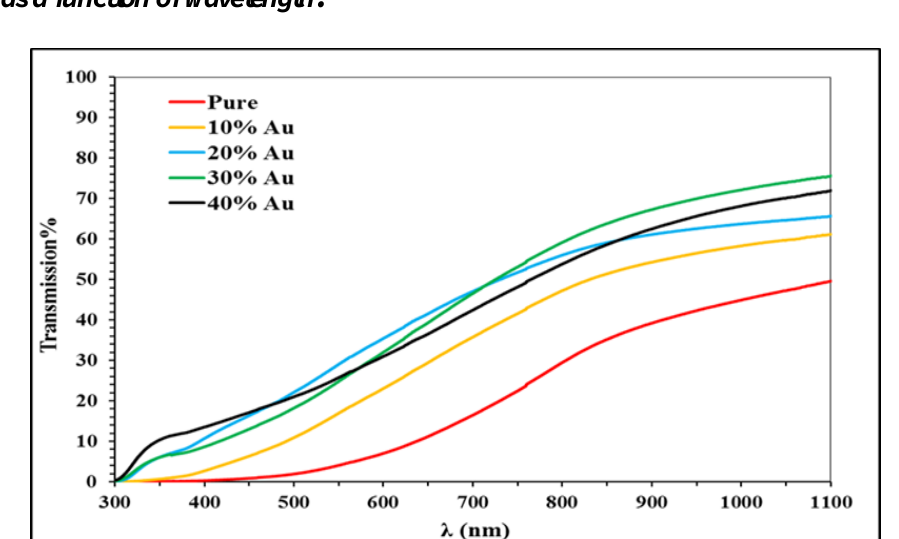
Fig. 5: The transmission spectrum for pureWO films as a function of wavelength.